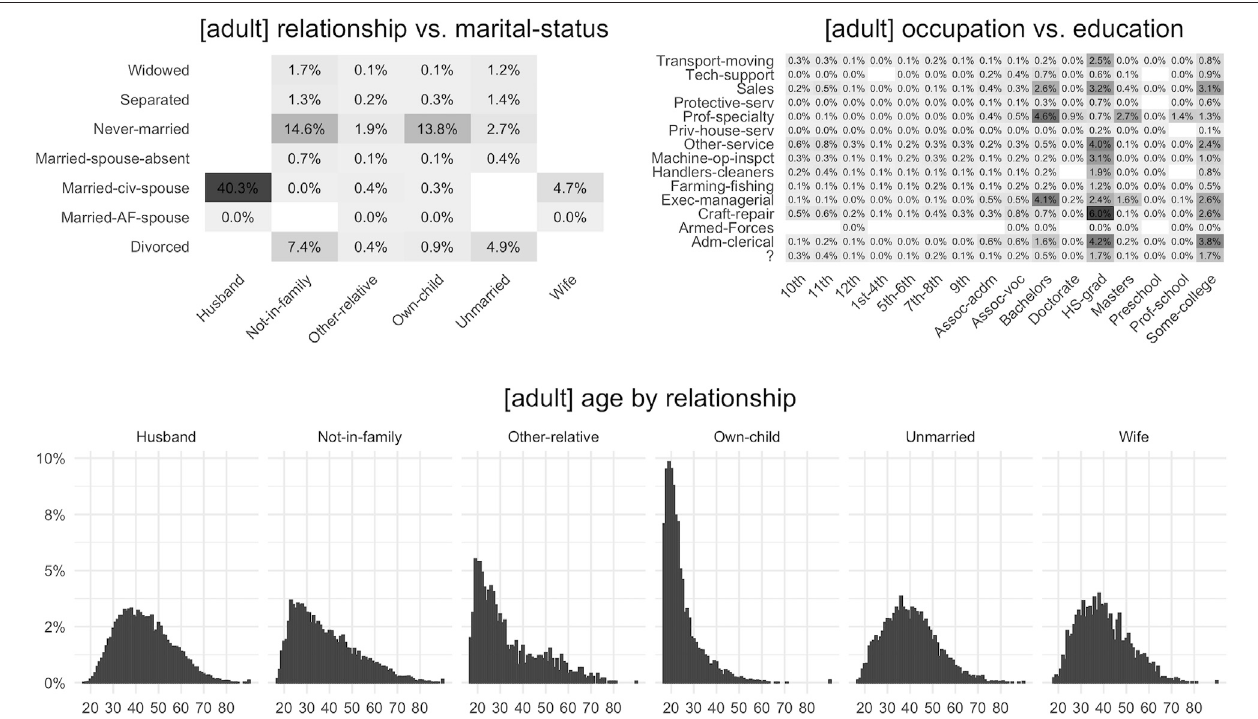
FIGURE 4 | Selected bivariate marginal distributions for dataset “ adult ” ; an accurate measure of data fi delity is expected to be fl exible enough to capture discrepancies of such distributional patterns.